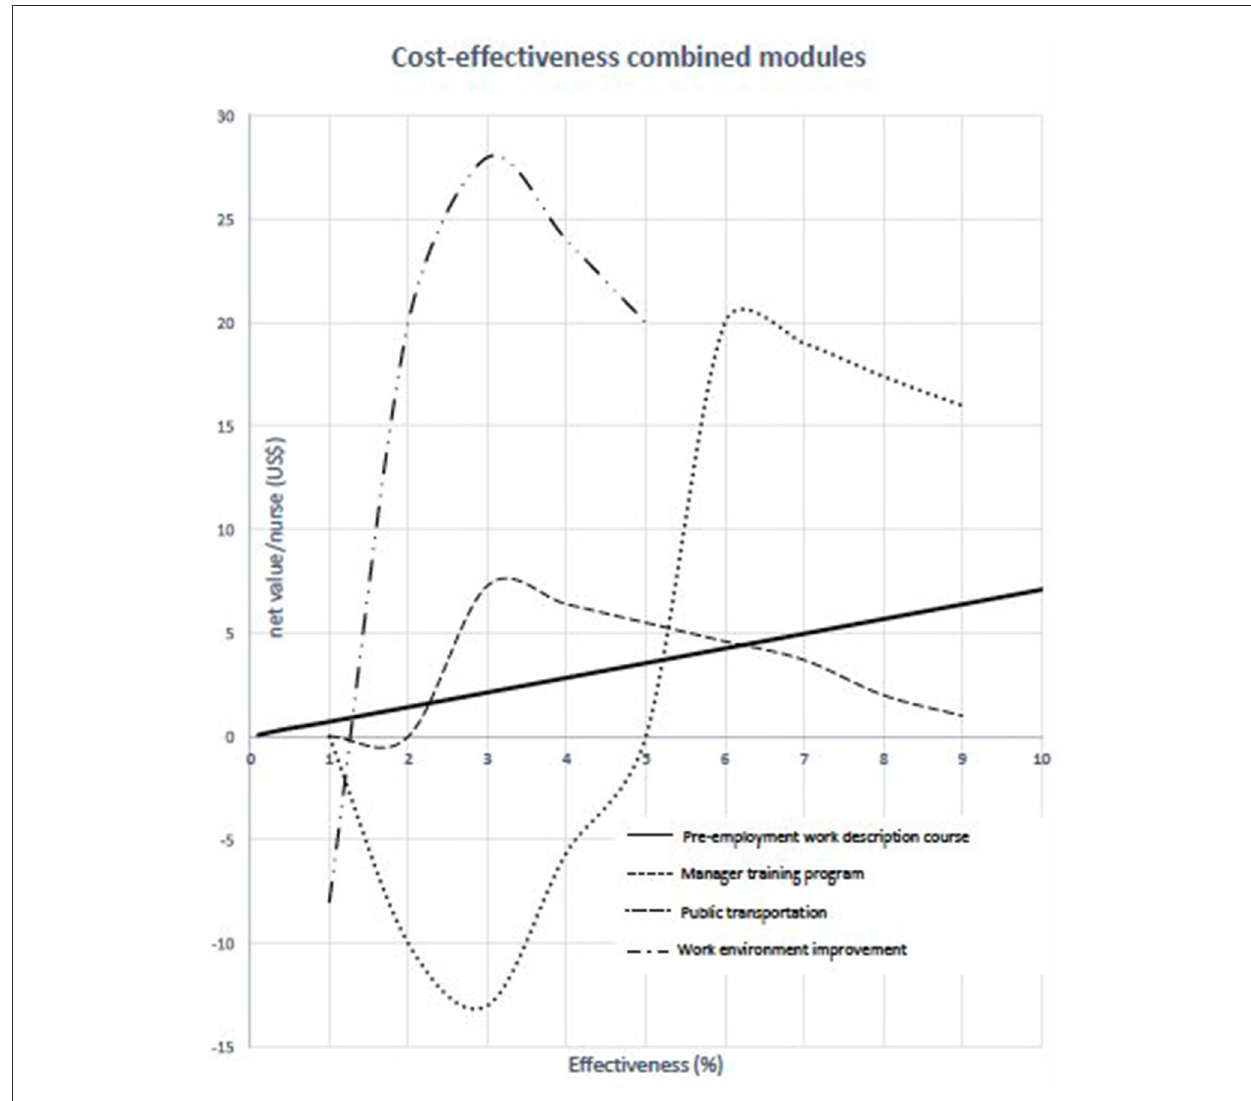
FIGURE1 The combined cost-effectiveness